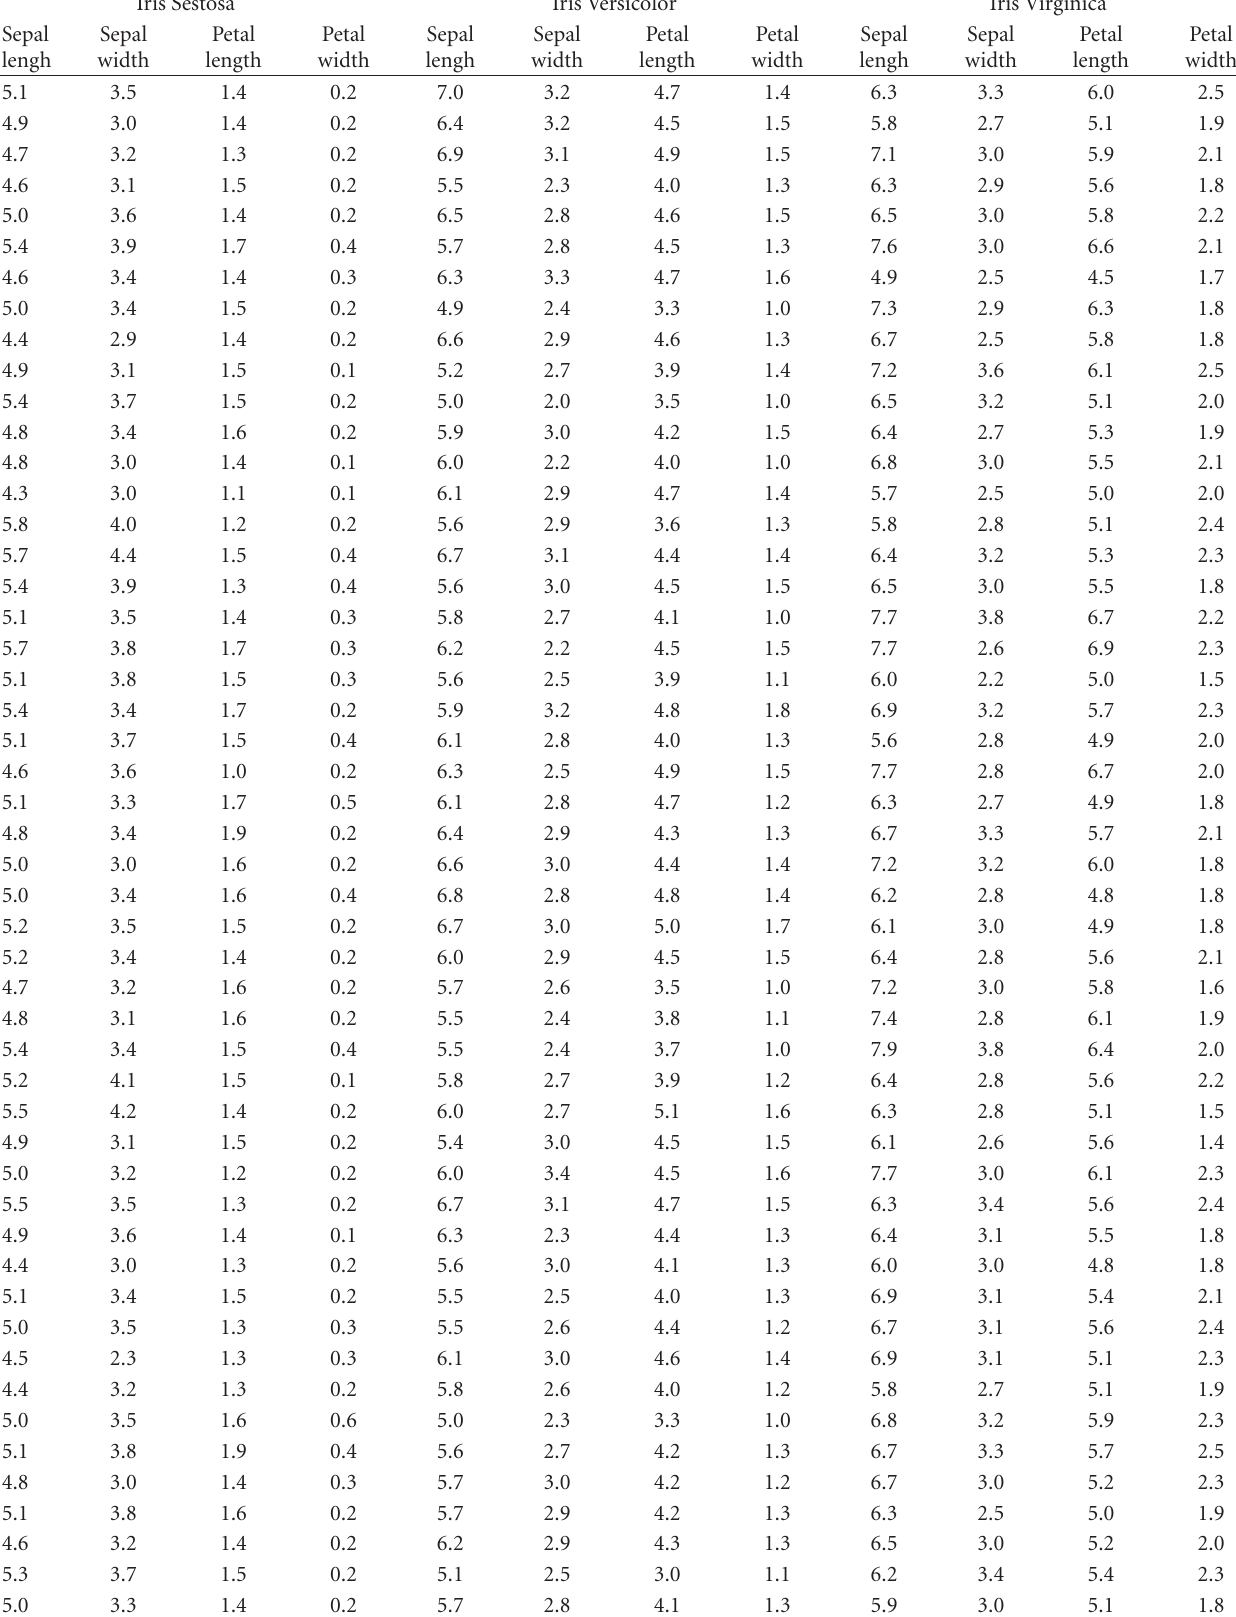
Table 1: Fisher’s Iris data [11] that were validated and compared to that reported by Bezdek et al. [12]. Iris